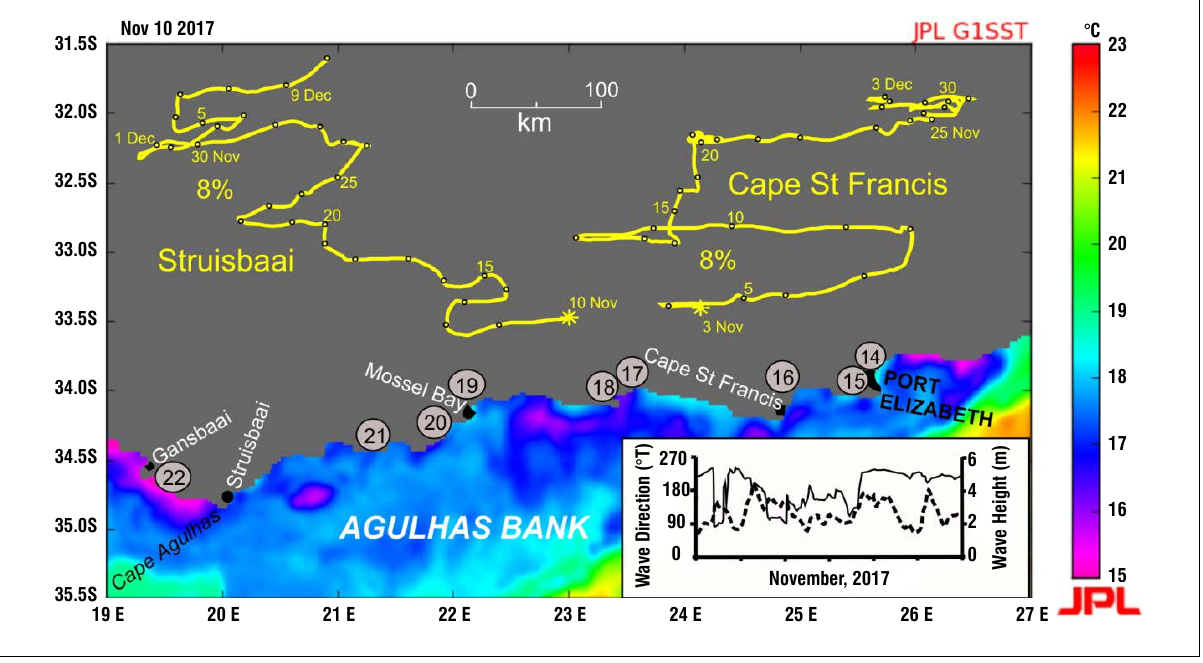
Figure 5: A satellite image for 10 November 2017, depicting sea surface temperatures (scale on right) off South Africa’s south coast. Sites listed in Table 1 of public reports of nurdles on beaches are shown. Progressive vector diagrams discussed in the text are shown, with day starts indicated by circles and day numbers in November and December. In the bottom right-hand corner, the hindcast wave direction and height (dotted) are given for 33°S and